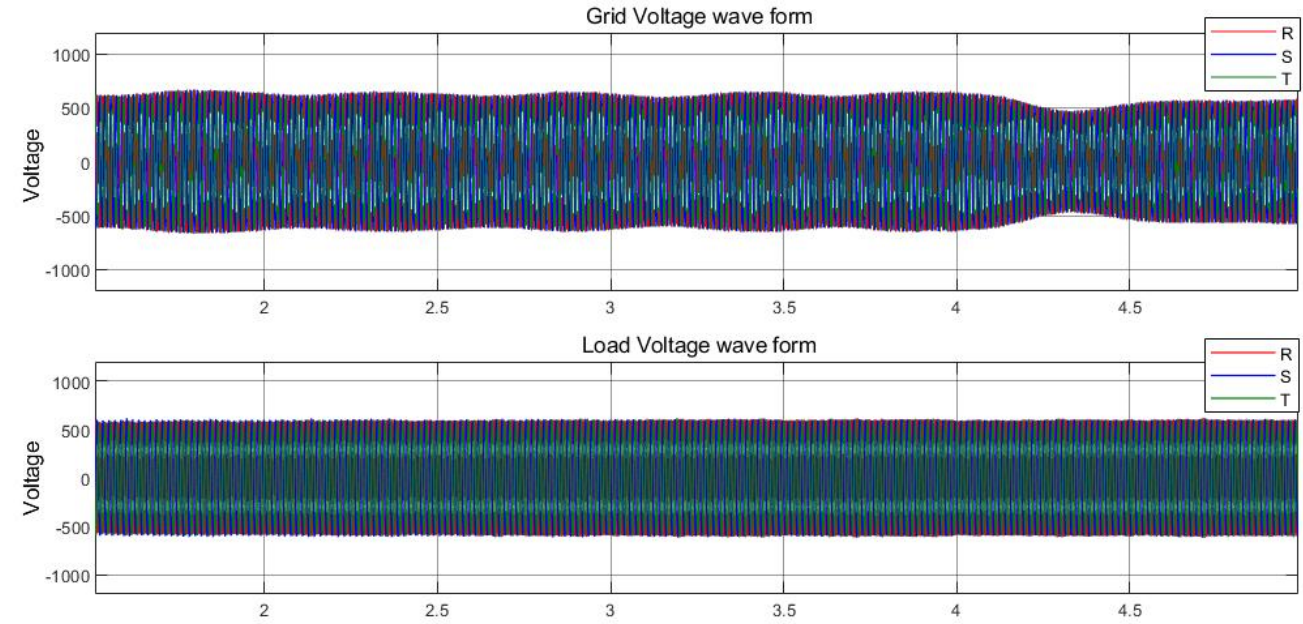
Figure 13. Load ‐ side voltage and grid ‐ side voltage amplitude with non ‐ linear load on the grid side using hysteresis.